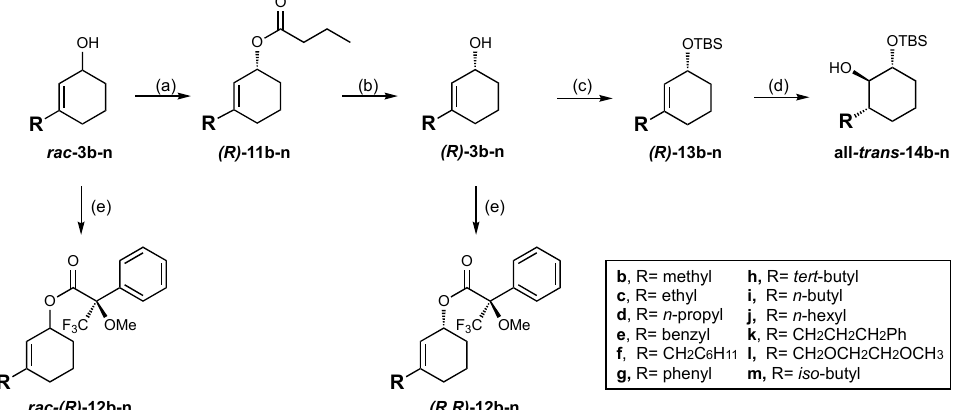
Figure 2. 19 F NMR spectra of Mosher esters ( R,R )–12b and rac ,( R )–12b obtained from rac –3b and ( R) –3b . for the 19 F NMR spectra of Mosher esters ( R,R )–12c-n see Table 1 and Supporting Infor-